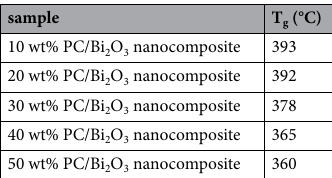
Table 5. DTA results for nanocomposites containing different levels of Bi 2 O 3